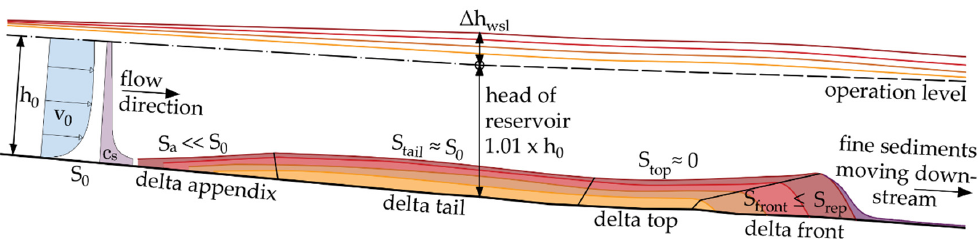
Figure 9. Spatio-temporal scheme of delta formation and corresponding water levels at the head of a run-of-river reservoir in medium-sized gravel bed rivers. Starting point is the bed slope S 0 , i.e., the dynamic equilibrium slope of the free-flowing section and parallel water surface profiles which merge into the turbine operation level at the head of the reservoir. S rep = the slope corresponding to the angle of repose of the sediment mixture.